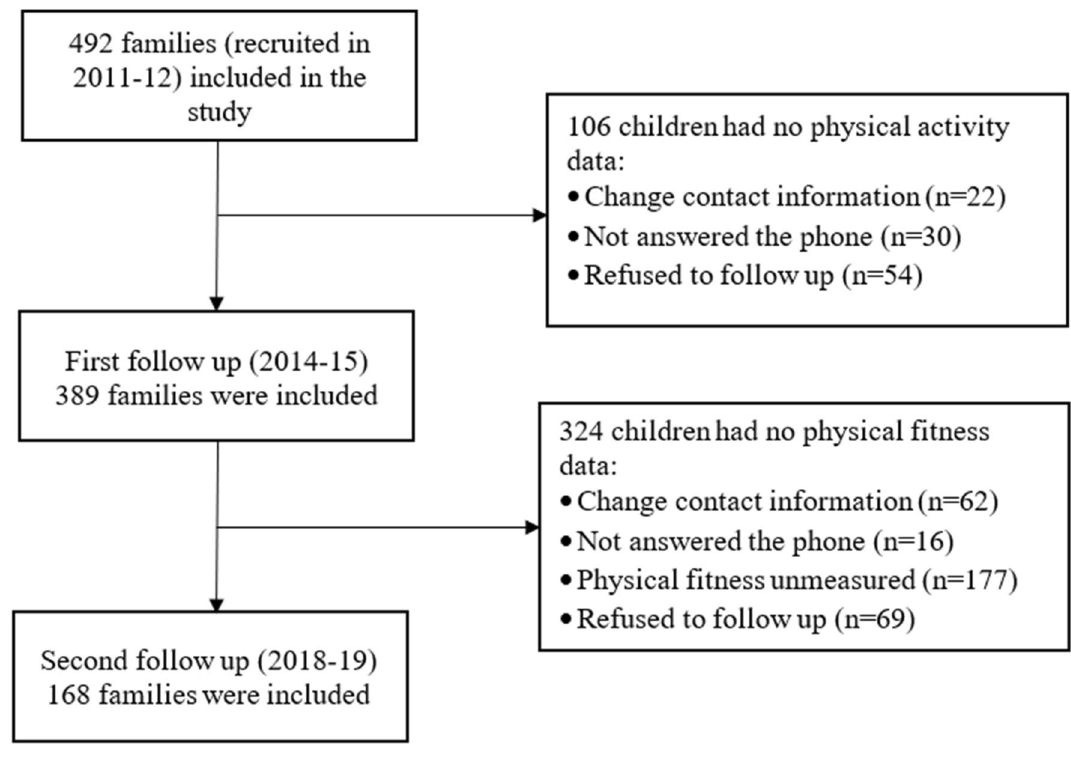
Figure 3. Study flow